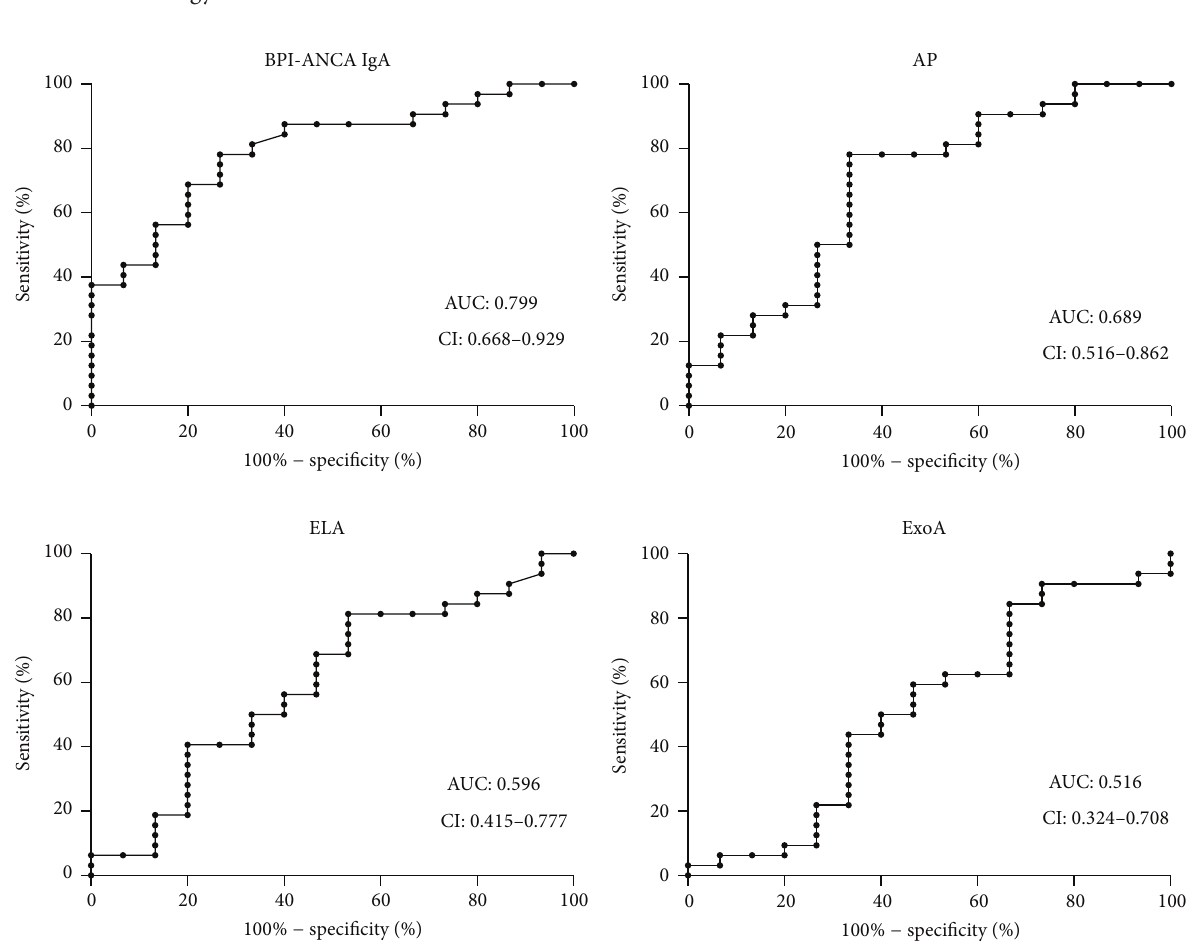
Figure 1: P. aeruginosa related lung damage. ROC-curves comparing how well the different tests identify patients chronically colonized with P. aeruginosa with an FEV1.0 below 80% of predicted ( 𝑛 = 32 ). IgA BPI-ANCA was the best test for this purpose, with an area under curve of 0.8 (CI: 0.688–0.929, 𝑝 value